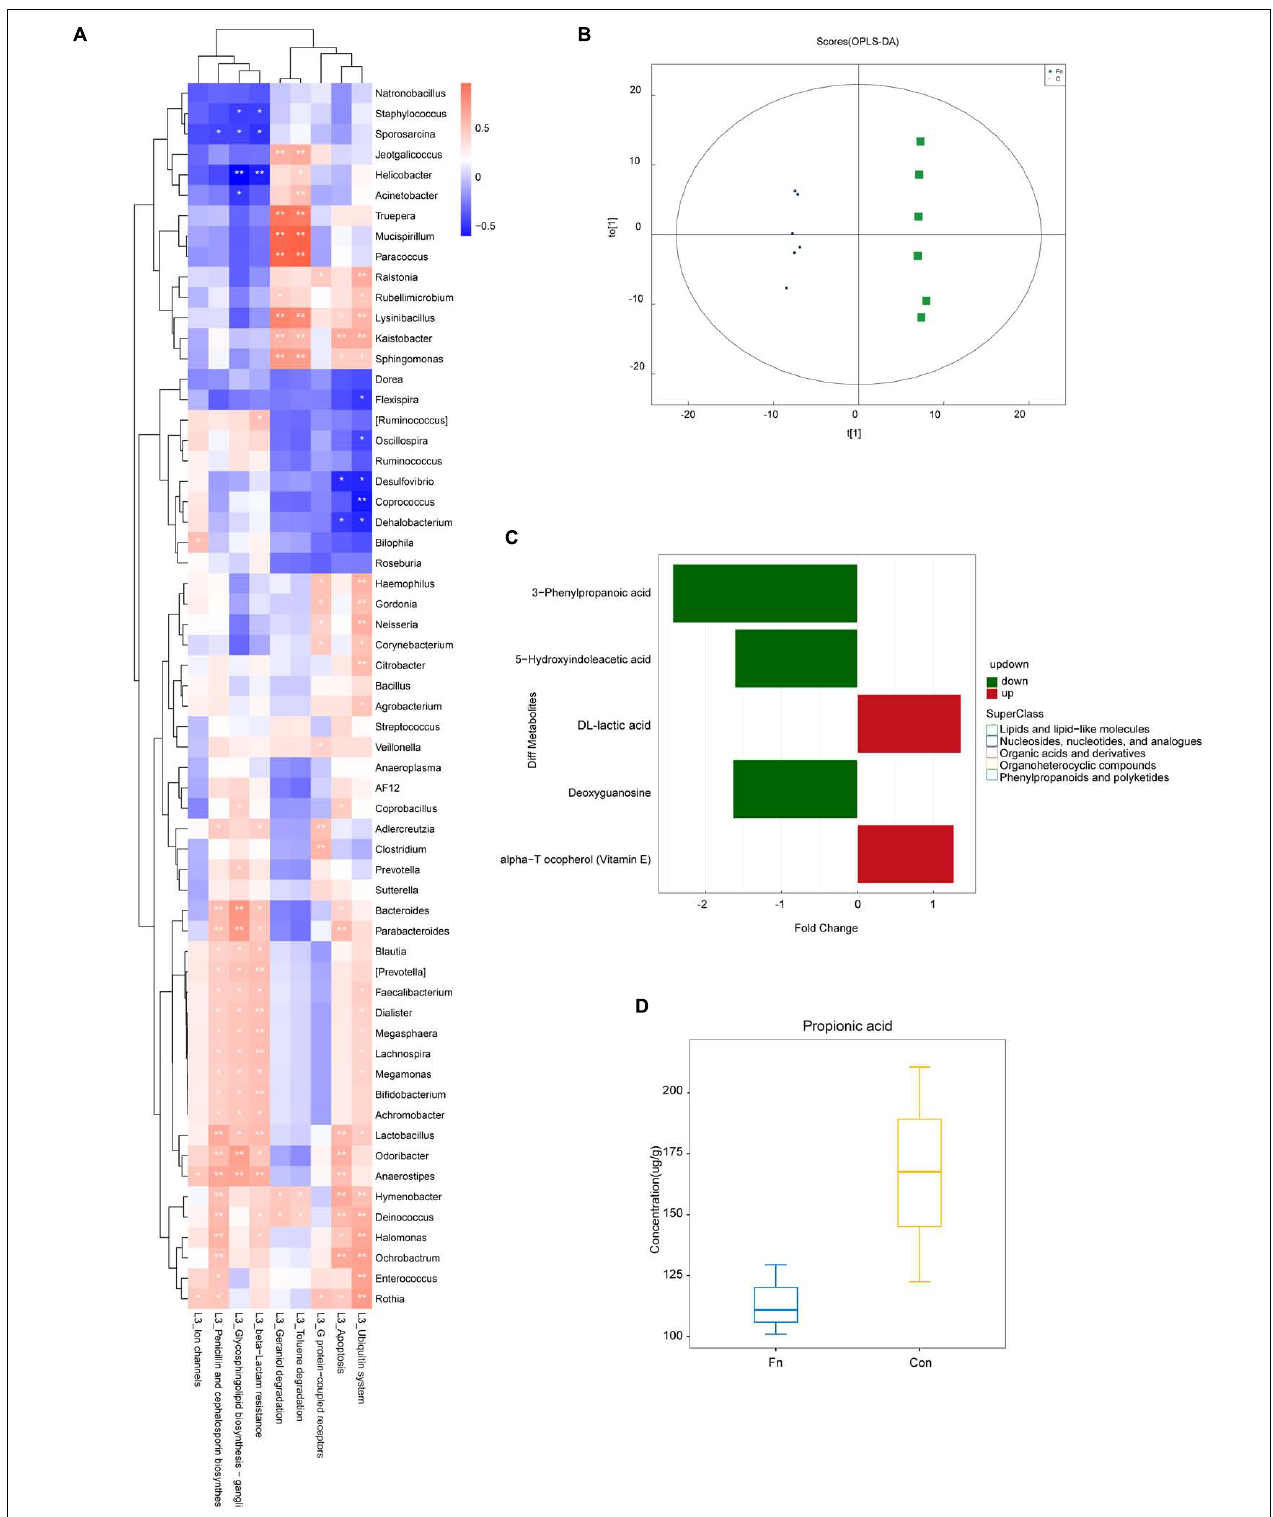
FIGURE 7 | KEGG pathway and metabolite analysis of the fecal samples from mice given Fn gavage. (A) Correlation analysis heat map of bacteria and KEGG pathways in Con and Fn groups. (B) OPLS-DA showed the stability of the template; (C) differential metabolites identified with non-targeted mass spectrometry; (D) propionic acid identified with targeted mass